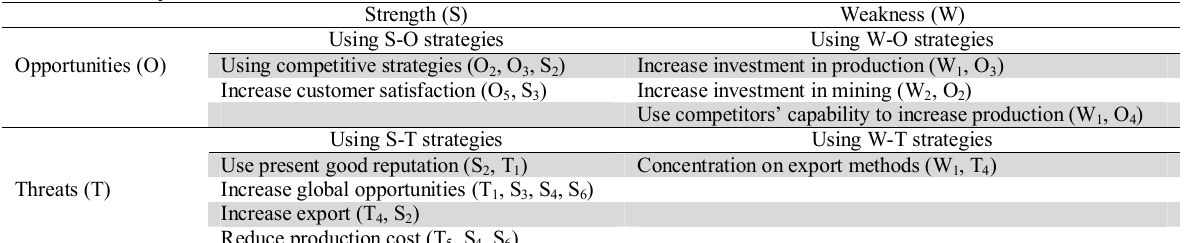
The summary of SWOT Strength (S) Weakness (W) Using S-O strategies Using W-O strategies Opportunities (O) Using competitive strategies (O 2 , O 3 , S 2 ) Increase investment in production (W 1 , O 3 ) Increase customer satisfaction (O 5 , S 3 )